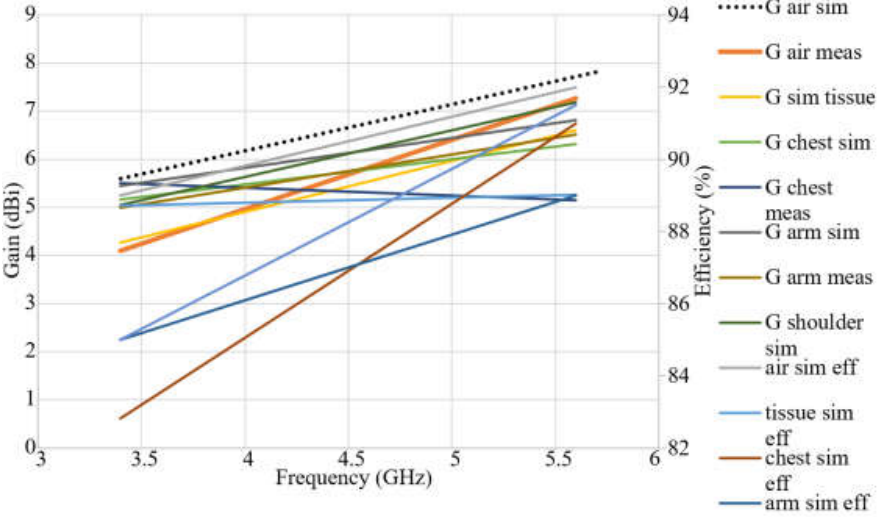
Figure 18. The simulated and measured gain and simulated radiation efficiency (‘sim’ is the simula- tion, ‘meas’ is the measurement, ‘G’ is the gain, and ‘eff’ is the radiation efficiency). After examining the antenna’s SAR values and proving that it works well on the human body with the least SAR and effects, the antenna’s robustness towards bending is assessed by checking the S-parameter results. The button and LWA components of the antenna were bent toward the X- and Y-axes individually to determine whether the antenna performs correctly when each section bends or crumples after being worn to study the effect of real-world wearable conditions on the antenna performance. Figure 19 shows the robustness testing of the antenna in the direction of both X (Figure 19a,c)- and Y (Figure 19b,d)-axes. As illustrated in Figure 19, the button and LWA elements of the antenna are bent up to 20 and 60 degrees, respectively, in both the X- and Y-axes.